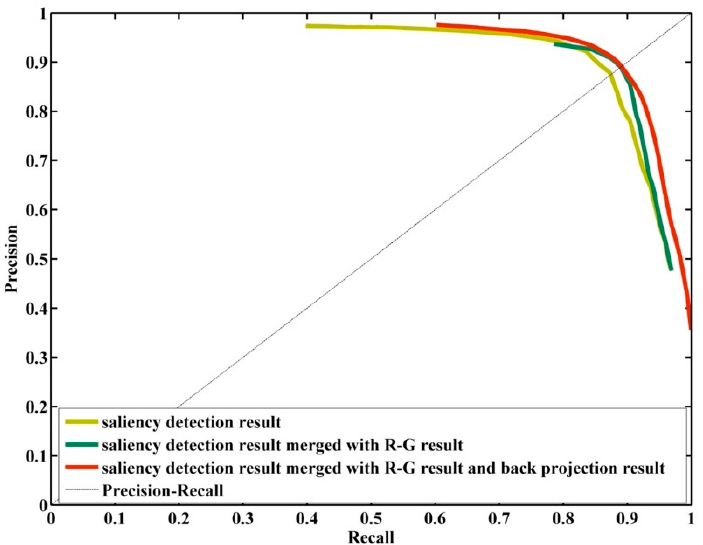
Figure 4. PR curve comparison of the results of each stage in the fusion improvement saliency map.